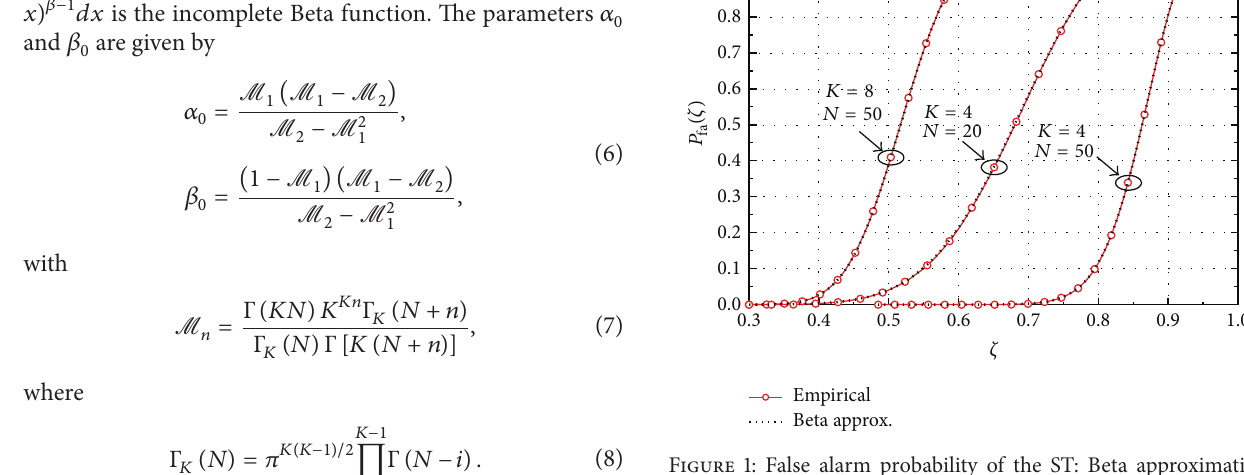
Figure 1: False alarm probability of the ST: Beta approximation versus simulation for 𝑃 = 3, and variable 𝐾 and 𝑁 .